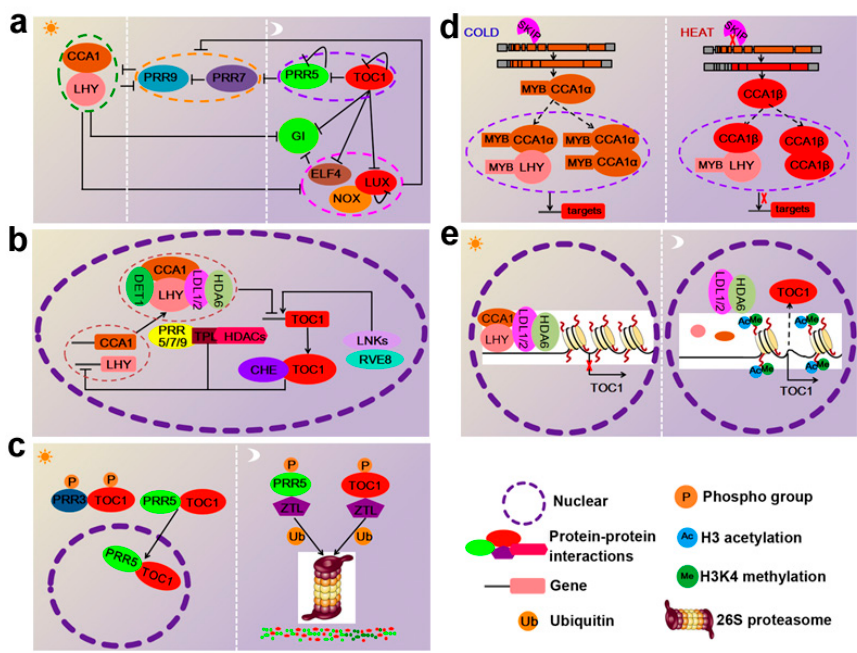
Figure 1. Multiple layers of regulation refine circadian clock activity in Arabidopsis thaliana .